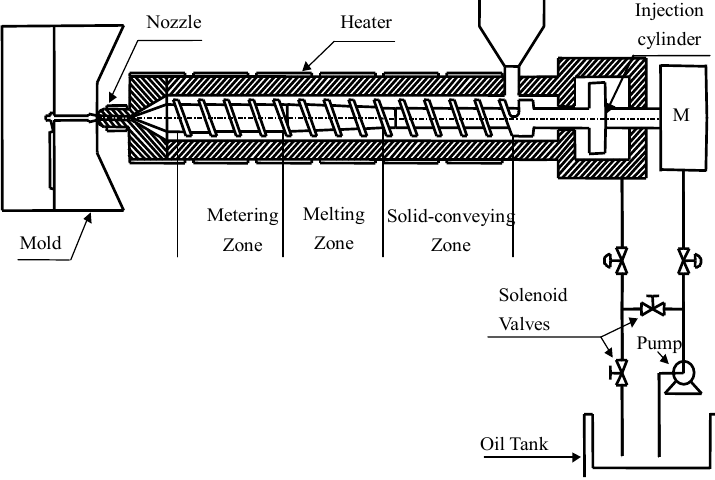
Figure 3. A simplified schematic diagram of injection molding